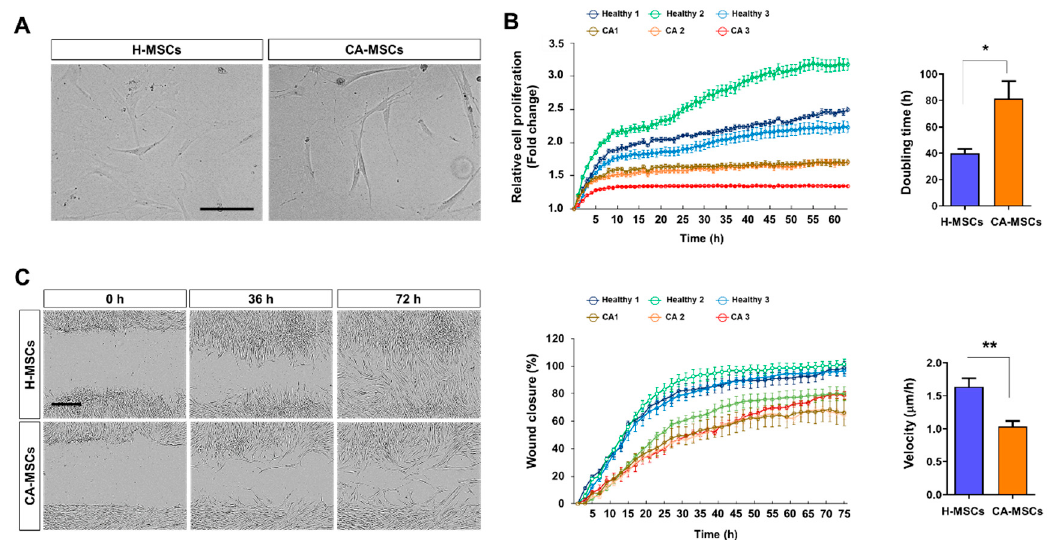
Figure 1. Comparison of the biological characteristics of mesenchymal stem cells (MSCs) derived from cerebellar ataxia patients (CA-MSCs) and healthy individuals (H-MSCs). ( A ) Comparison of the morphology of H-MSCs and CA-MSCs. Scale bar = 200 µ m. ( B ) Comparison of the proliferation of H-MSCs and CA-MSCs. The cell proliferation rate was assessed using the IncuCyte Time-lapse Microscopy System and was presented as fold change of cell density. Right panel shows doubling time of MSCs. ( C ) Scratch-wound healing assay. Representative bright-field images showing the migration potential of MSCs at 0, 36, and 72 h after wound scratch. Scale bar = 400 µ m. In vitro cell migration and wound closure were assessed every 2 h. The scratch gap was calculated as a percentage of the relative cell density based on the initial wound area (middle panel). Right panel shows the velocity ( µ m / h) of wound closure. Error bars indicate the standard deviation of three replicate experiments. Data are presented as mean ± SEM. One-way analysis of variance was followed by the Tukey post-hoc test. * p < 0.05, ** p < 0.01.